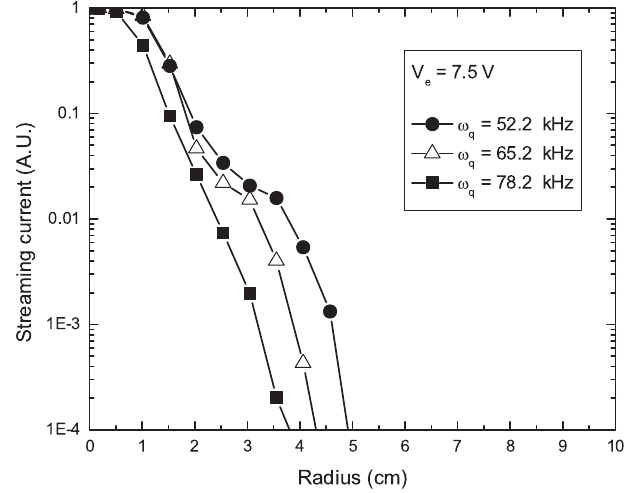
FIG. 3. Radial profiles of the axial streaming currents for several different smooth-focusing frequencies with fixed extrac- (cid:2) 7 : 5 V . tion voltage V e